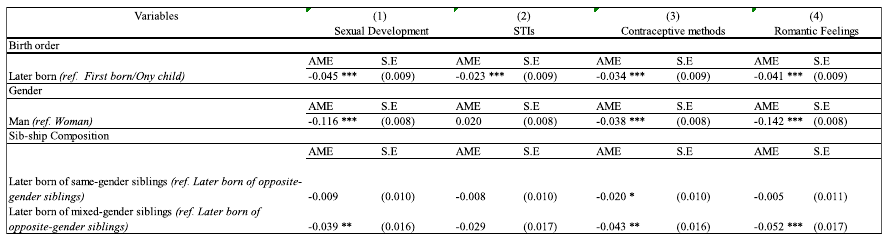
Source: SELFY (2000 and 2017) Note: N = 12,160 for hypothesis 1 and 3. N = 6,213 for hypothesis 3; Average Marginal Effects (AMEs) with